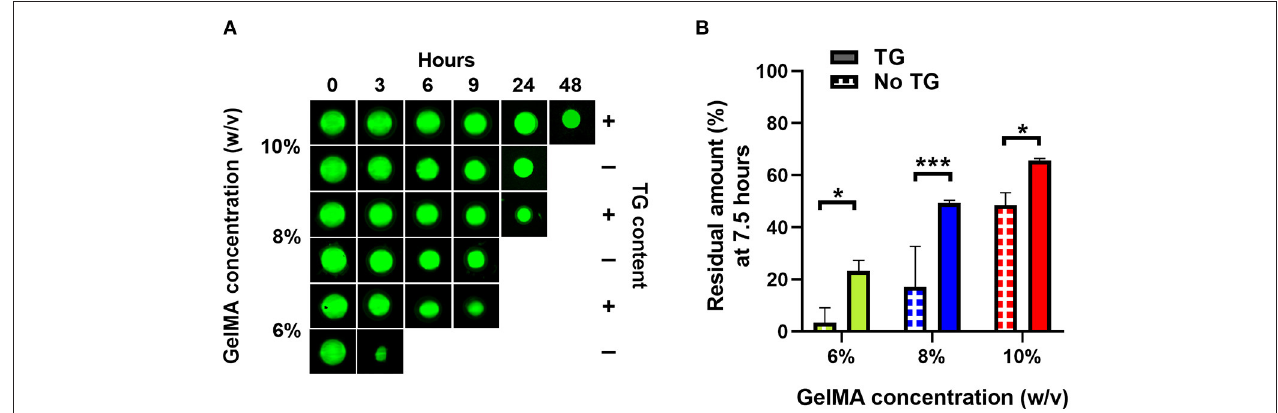
FIGURE 3 | Enzymatic degradation of GelMA with and without transglutaminase at different substrate concentrations. (A) Fluorescence imaging of GelMA scaffolds at 10, 8, and 6% concentrations, without and with transglutaminase after incubation for different times in PBS containing collagenase type II (5 U/ml). (B) Residual amounts of scaffolds remaining after 7.5h incubation calculated via cumulative loss of fluorescent material for GelMA scaffolds at three concentrations, both without and with transglutaminase. Data points are means with standard deviation for three scaffolds for each condition. Significance was assessed using a two-way ANOVA